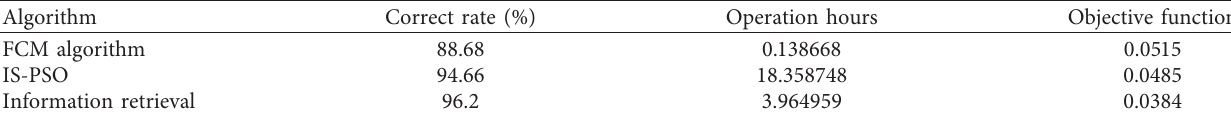
Table 6: Comparison of average performance of algorithms.